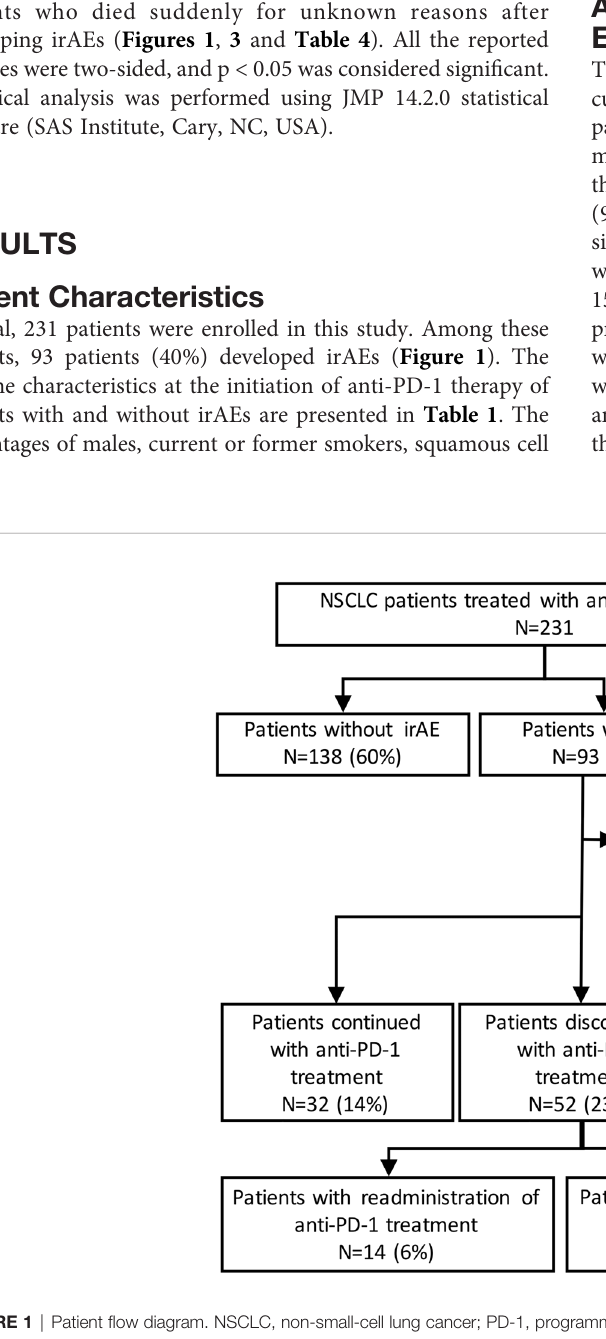
FIGURE 1 | Patient fl ow diagram. NSCLC, non-small-cell lung cancer; PD-1, programmed cell death-1; irAE, immune-related adverse